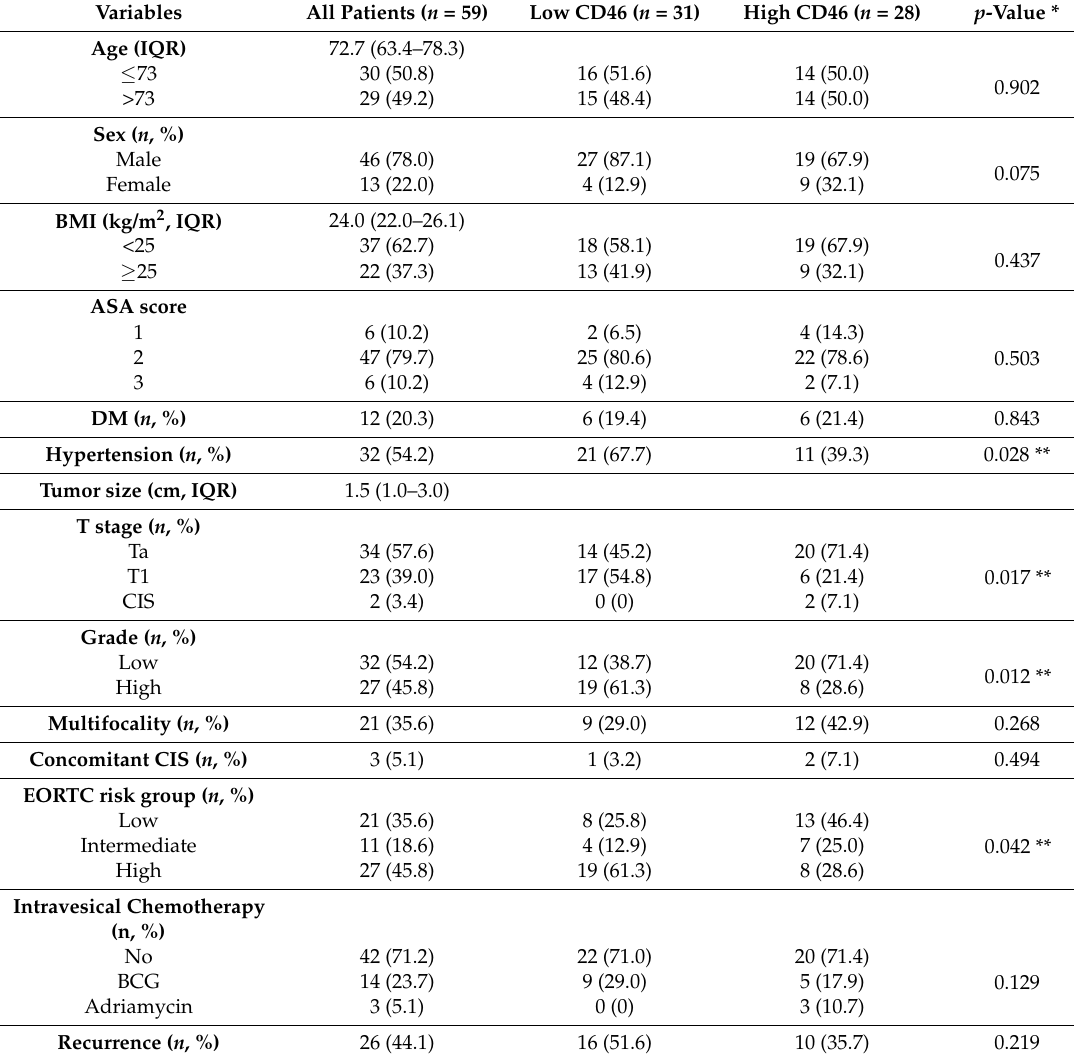
Table 1. Correlation between CD46 expression and clinico-pathological features in patients with bladder